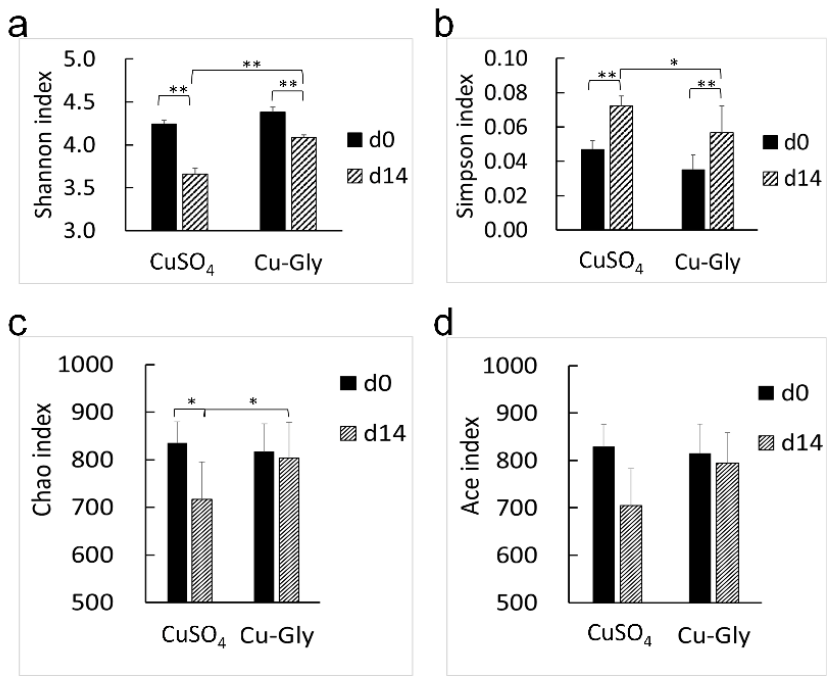
Figure 4. Effects of Cu sources on the alpha diversity of the microbial community in the feces of pigs. The Shannon ( a ), Simpson ( b ), Ace ( c ), and Chao ( d ) indices were calculated. Data present mean values ± standard errors. * represents a significant difference at p < 0.05, and ** represents a significant difference at p < 0.01. n = 6.